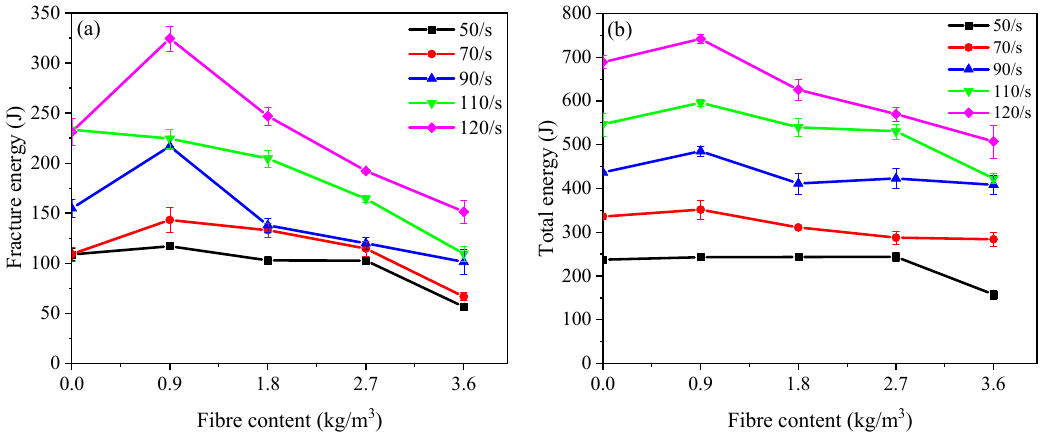
Figure 12. Energy absorption capacity of concrete reinforced with various polypropylene fibre content: ( a ) Fracture energy; ( b ) Total energy.